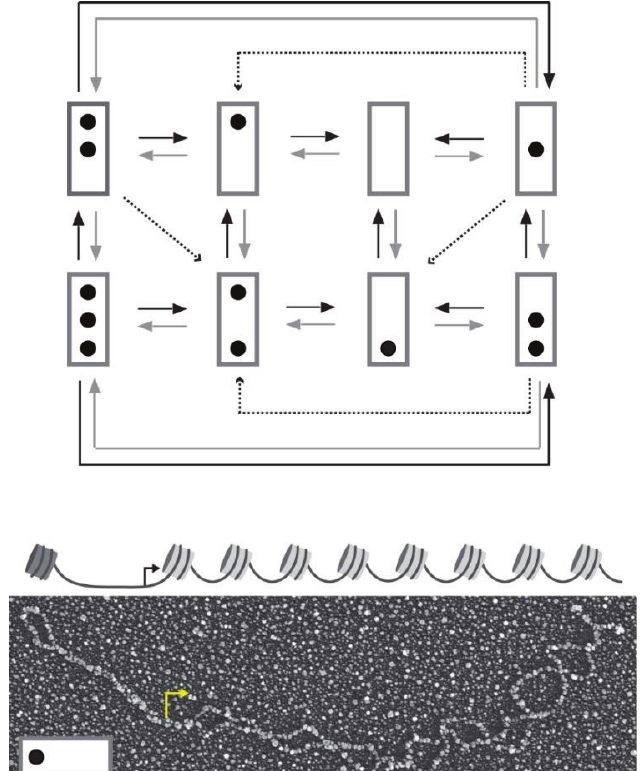
Figure 1. Transition graph for the stochastic dynamics of PHO 5 promoter nucleosomes (top). The promoter is represented by a box and occupied nucleosome positions as dots. Nucleosome positions from top to bottom are called N-1 to N-3. N-1 contains the transcription start site. Black, gray, and dashed arrows indicate assembly, disassembly, and sliding transitions, respectively. At the bottom is the electron micrograph of an isolated PHO5 molecule after psoralen-crosslinking, DNA denaturation, and heavy metal shadowing. Positions previously occupied by nucleosomes appear as single-stranded DNA “ bubbles ” (for psoralen crosslinks linker DNA, but not DNA within the nucleosome core particle). Nucleosome position N-3 is occupied, but not positions N-2 and N-1 (see reconstruction above electron micrograph with promoter nucleosomes in dark gray and nucleosomes over open reading frame in light gray) [4]. A bent arrow indicates the transcription start